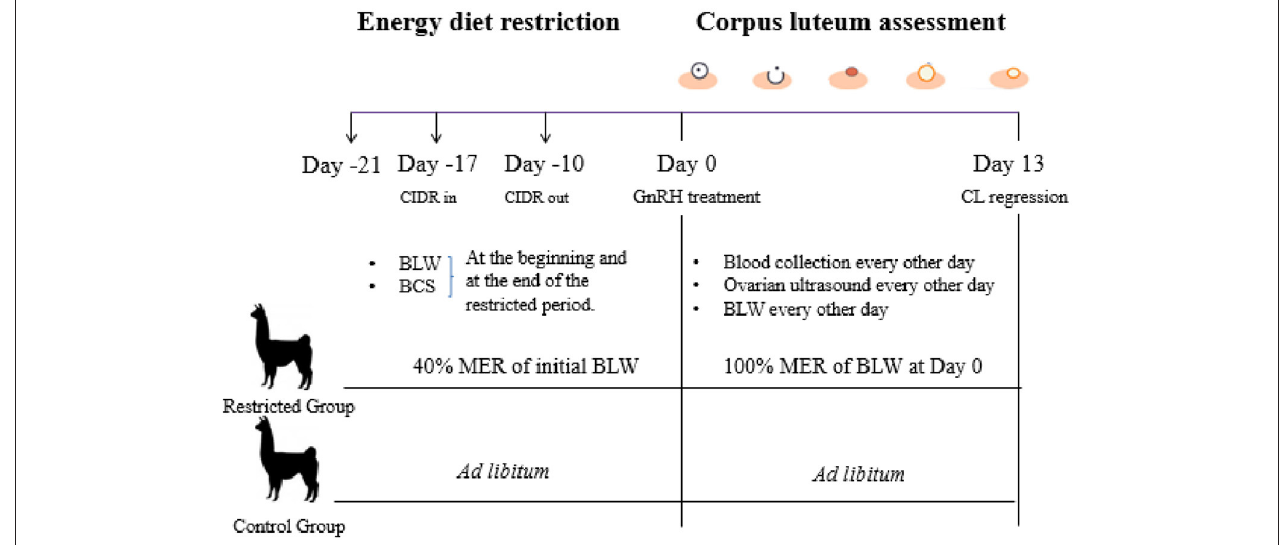
FIGURE 1 | Experimental design of Experiment